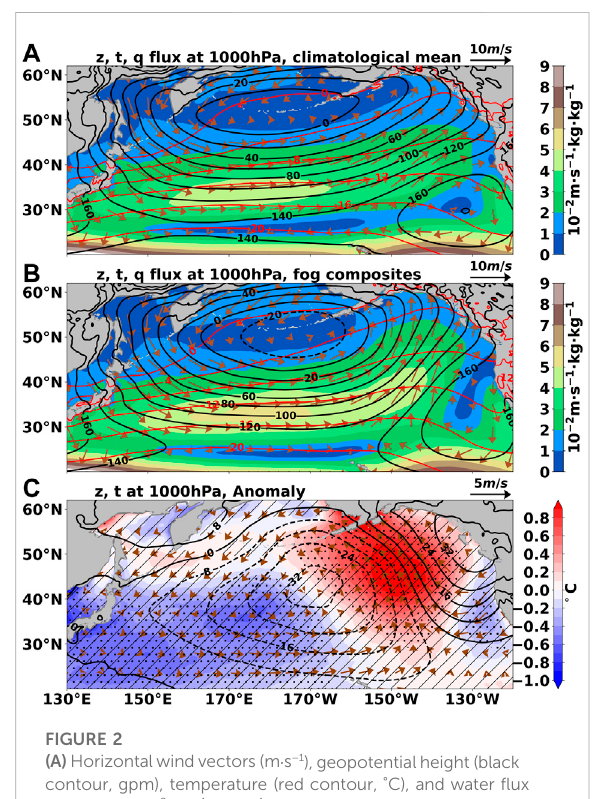
FIGURE 2 (A) Horizontalwindvectors(m · s − 1 ),geopotentialheight(black contour, gpm), temperature (red contour, ° C), and water fl ux (shaded, in 10 − 2 m · s − 1 · kg · kg − 1 ) at 1000 hPa in winter for the climate state. (B) Same as (A) but for NEP fog composite in winter (C) anomaly for the NEP fog composite: Geopotential height (black contour, in gpm), temperature (shaded, ° C), and horizontal wind (vectors, m · s − 1 ). The black dots denote that the temperature anomaly is signi fi cant at the 95% con fi dence level based on the Student ’ s t- test. The shade lines indicate the geopotential height anomaly signi fi cant at the 95% con fi dence